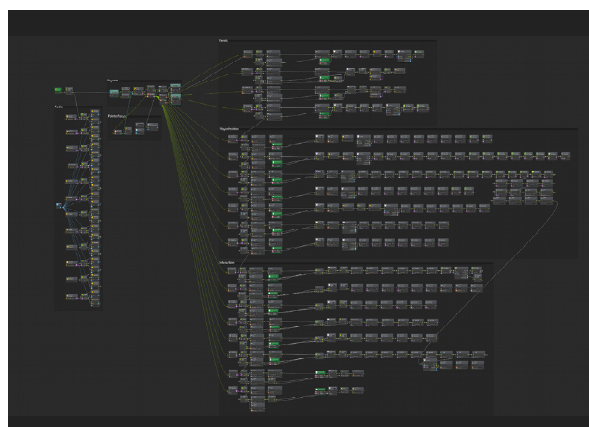
Figure 14 . AR experience with 3D reconstruction of the Gandhāra Buddha.